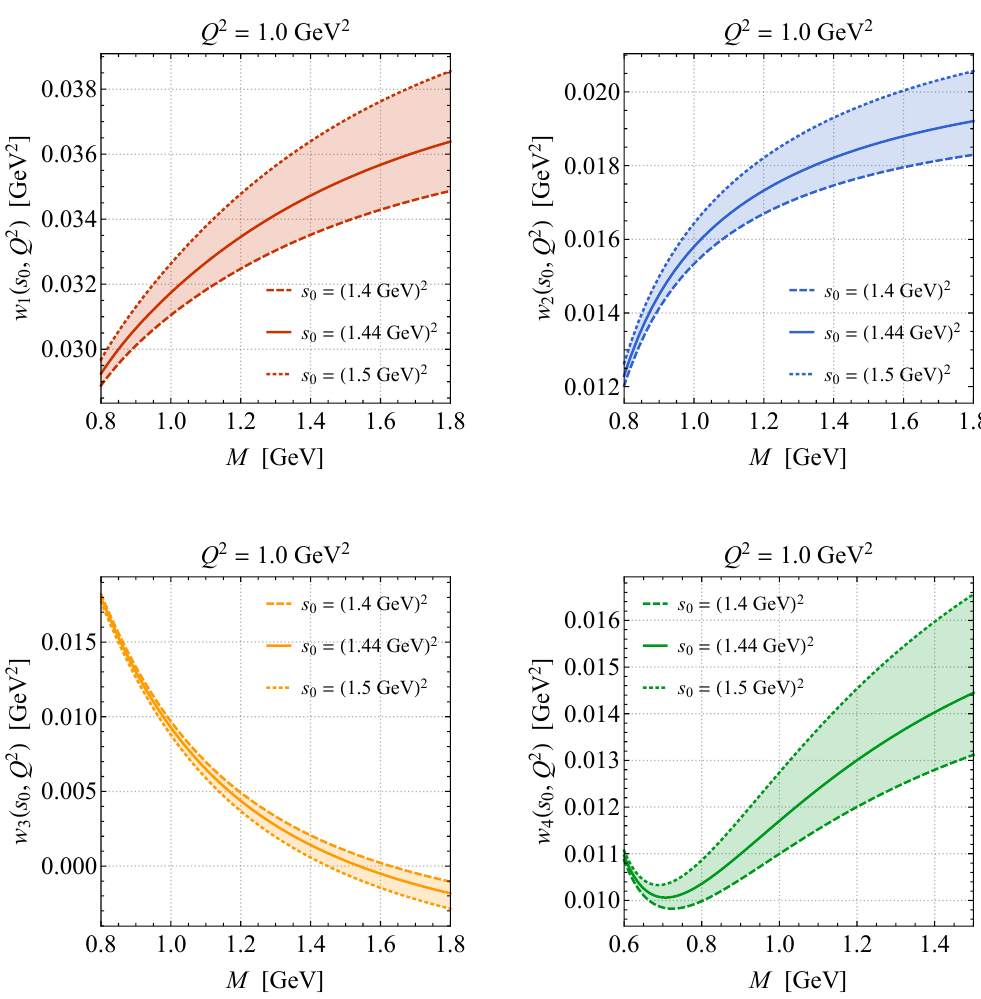
Figure 1 . Form factors w n ( s 0 , Q 2 ) as a function of the Borel mass M for three different values of the continuum threshold s 0 . All plots show the results at Q 2 = 1 GeV 2